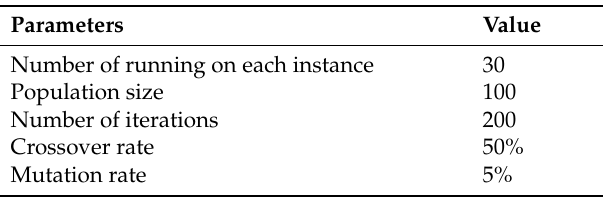
Table 5. Parameters setting for GAMEP [39].